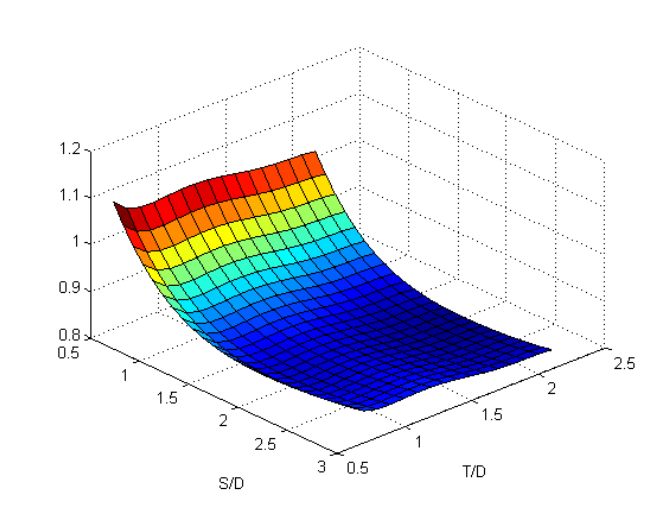
Figure 7. Mathematical model plot of the reduction of the drag